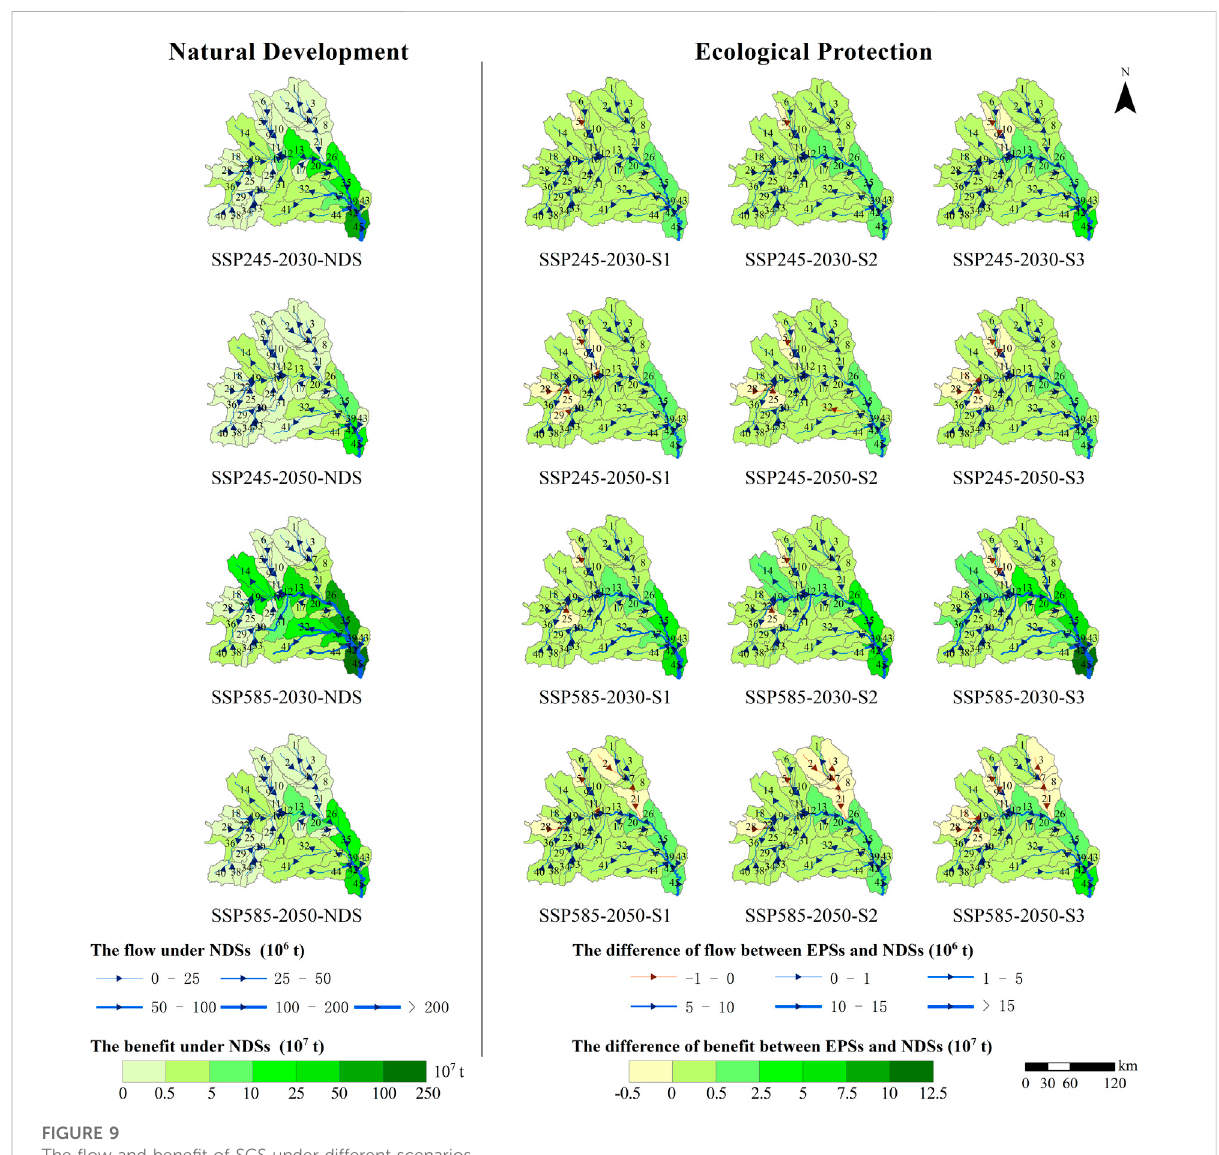
FIGURE 9 The fl ow and bene fi t of SCS under different